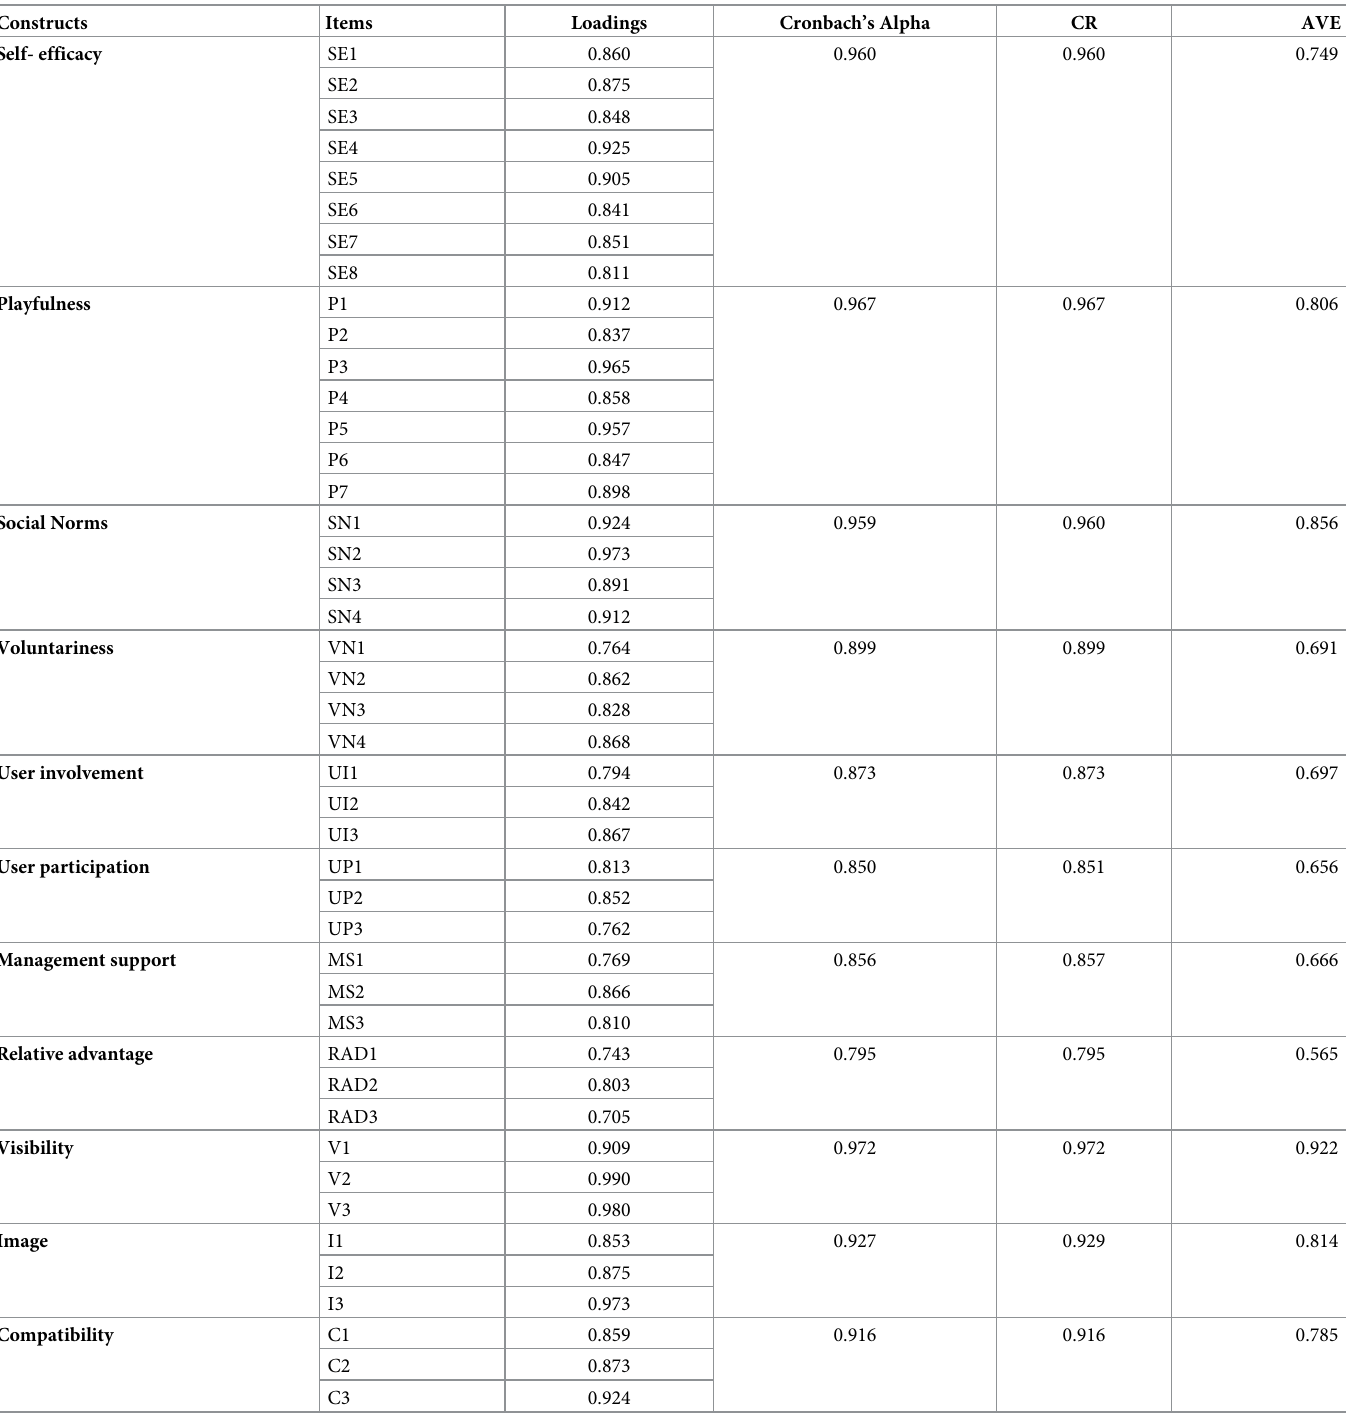
Table 2. Results of factor loadings, Cronbach’s alpha, CR, and